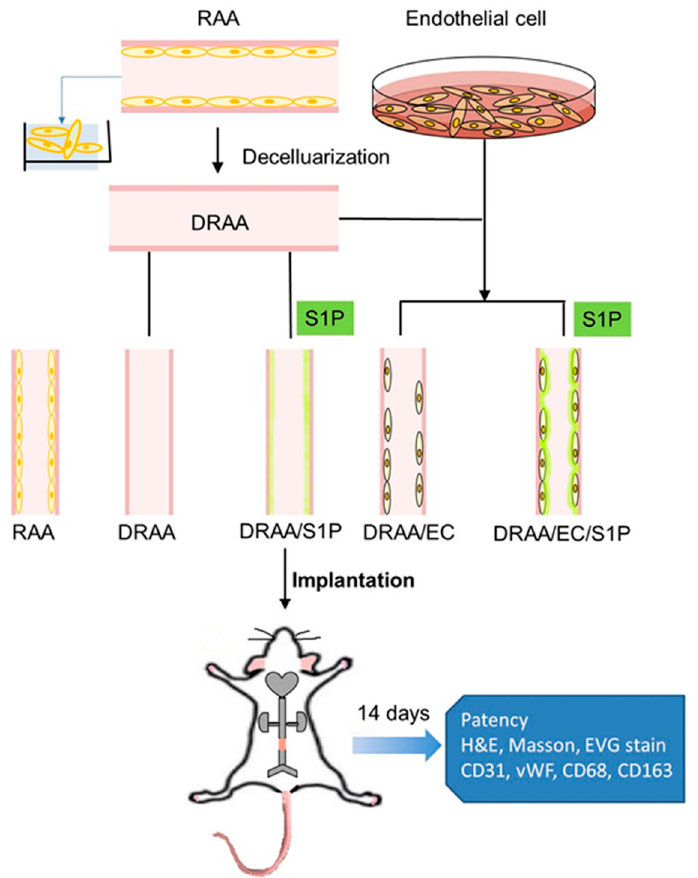
Figure 7. Schematic diagram of the experiment. The TEBV was constructed by decellularized rat abdominal aorta and rat ECs. S1P was added for 48 h to the ECs while seeding on the scaffold. To evaluate the anti-thrombotic effect of S1P on this small caliber vascular, the RAA, DRAA, DRAA with S1P and DRAA seeded by EC only were implanted into rat aorta separately ( n = 6).